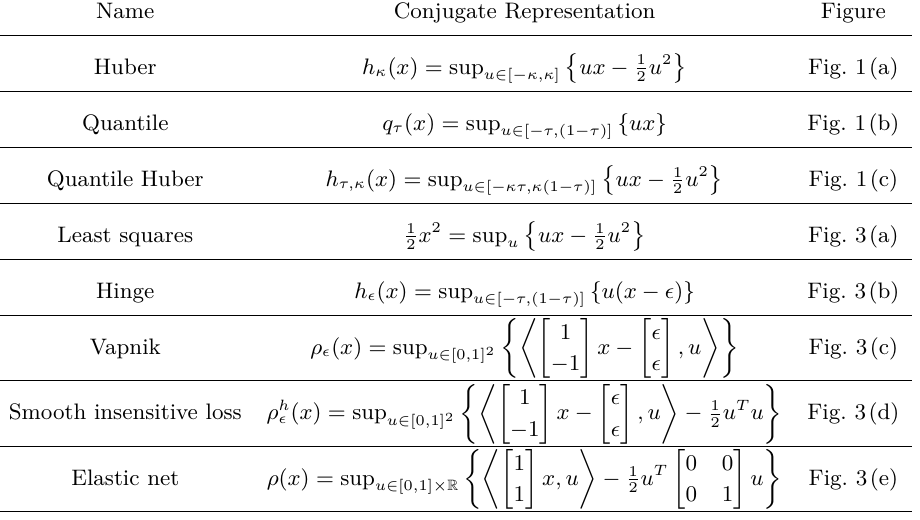
Table 1 Common PLQ Functions and their Conjugate Representations Name Conjugate